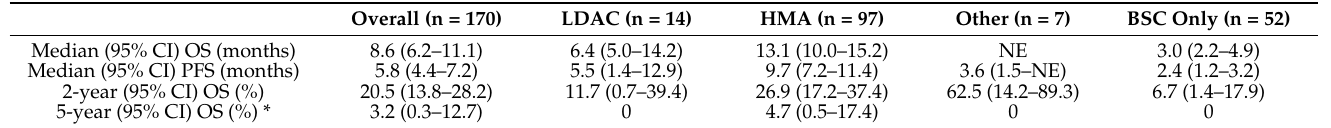
Table 2. Kaplan–Meier estimates of survival.